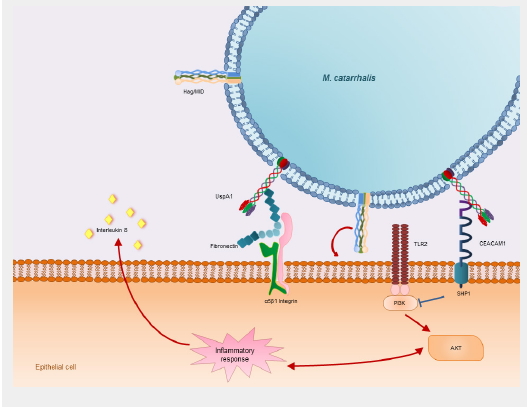
Adherence to host epithelial cells. UspA1 activates the carcino- embryonic antigen-related cell adhesion molecule 1 (CEACAM 1). Binding and activating of CEACAM 1 leads to recruitment of the SH2 containing protein tyrosin phosphatase 1 (SHP1). SHP1 inhibits the phosphoinositide 3-kinase (PI3K) phosphorylation which leads to a suppression of the AKT-mediated pro-inflammatory response. Furthermore UspA1 binds to the extracellular matrix glycoprotein fibronectin which in turn binds to α5β1 Integrin on the surface of the host epithelial cells. Hag/MID is known to be involved in the adherence of M. catarrhalis to host epithelial cells. The exact mechanism and the receptors involved are not yet